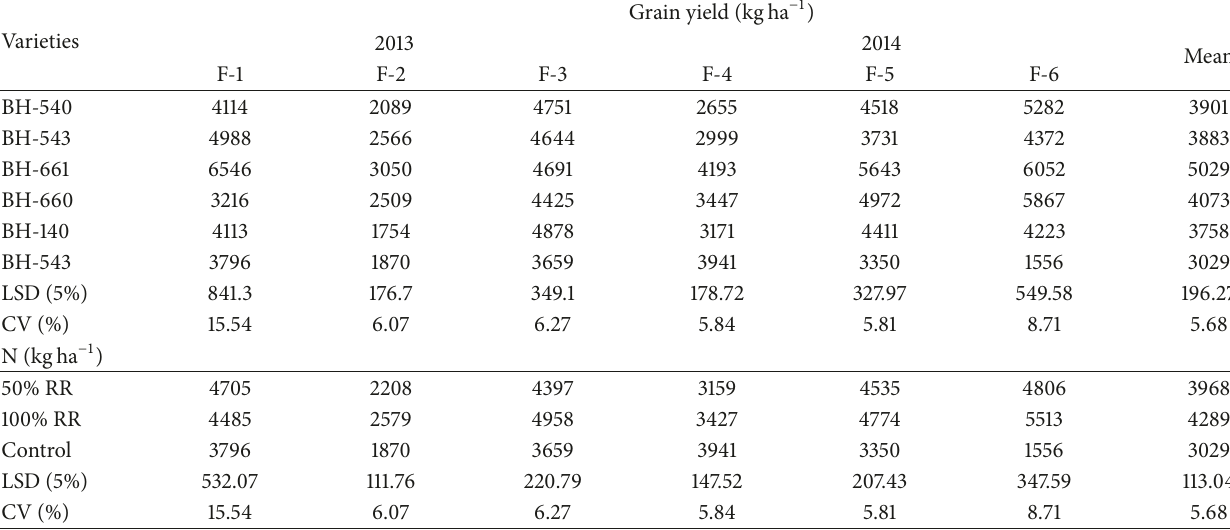
Table 6: Effects of varieties and nitrogen rate on mean number of grain yield of maize on farmer’s field around Bako Tibe, western Ethiopia.